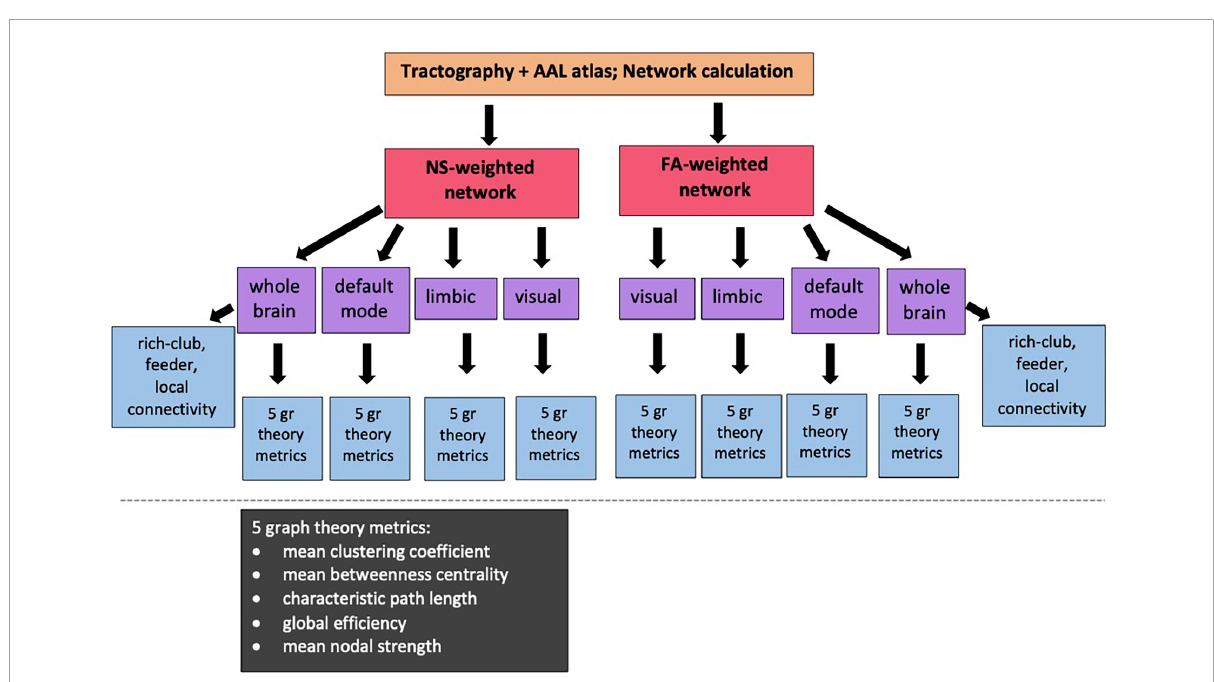
FIGURE2 Diagram showing the sub/networks used in our analysis and the graph theoretical and connectivity metrics that are correlated with the PRS. NS: number of streamlines; FA: fractional anisotropy of the diffusion